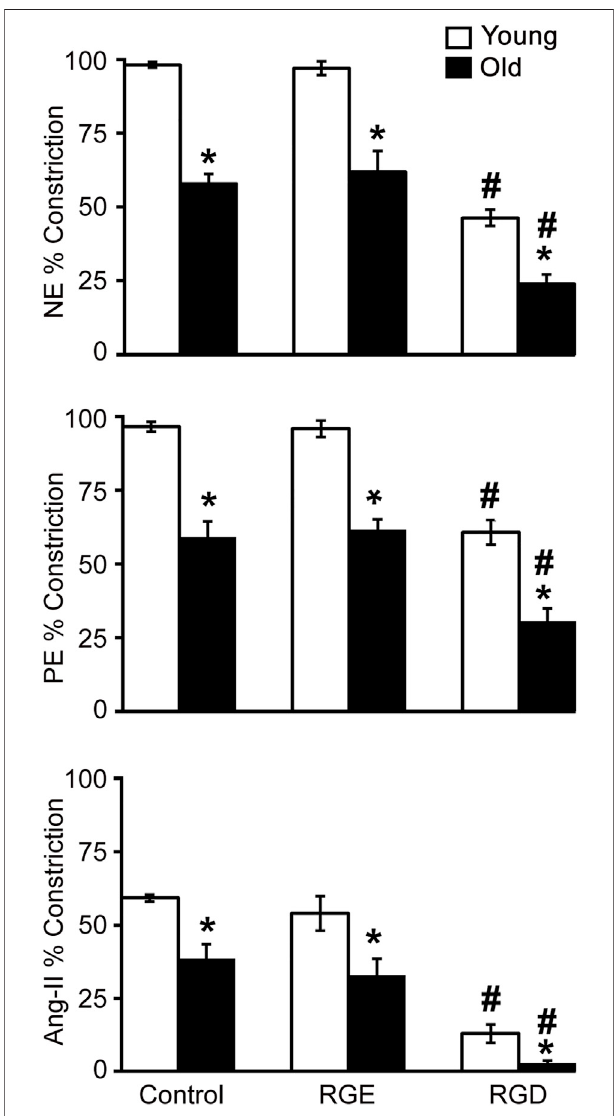
FIGURE 1 | The role of integrin signaling in agonist-induced constrictor responses with age was assessed in the presence of a functional integrin blockingRGDpeptide,anon-blockingRGEpeptide,andcontrolnotreatment condition. Maximal constrictor responses to NE (10 – 4 M), PE (10 – 4 M), andAngII(10 – 7 M)inSFAarepresented. n =5 – 12ratspergroup.Datashown are mean ± SE. Signi fi cance was evaluated at p < 0.05. *Values are signi fi cantly different from young. # Values are signi fi cantly different from age- matched control and RGE group.